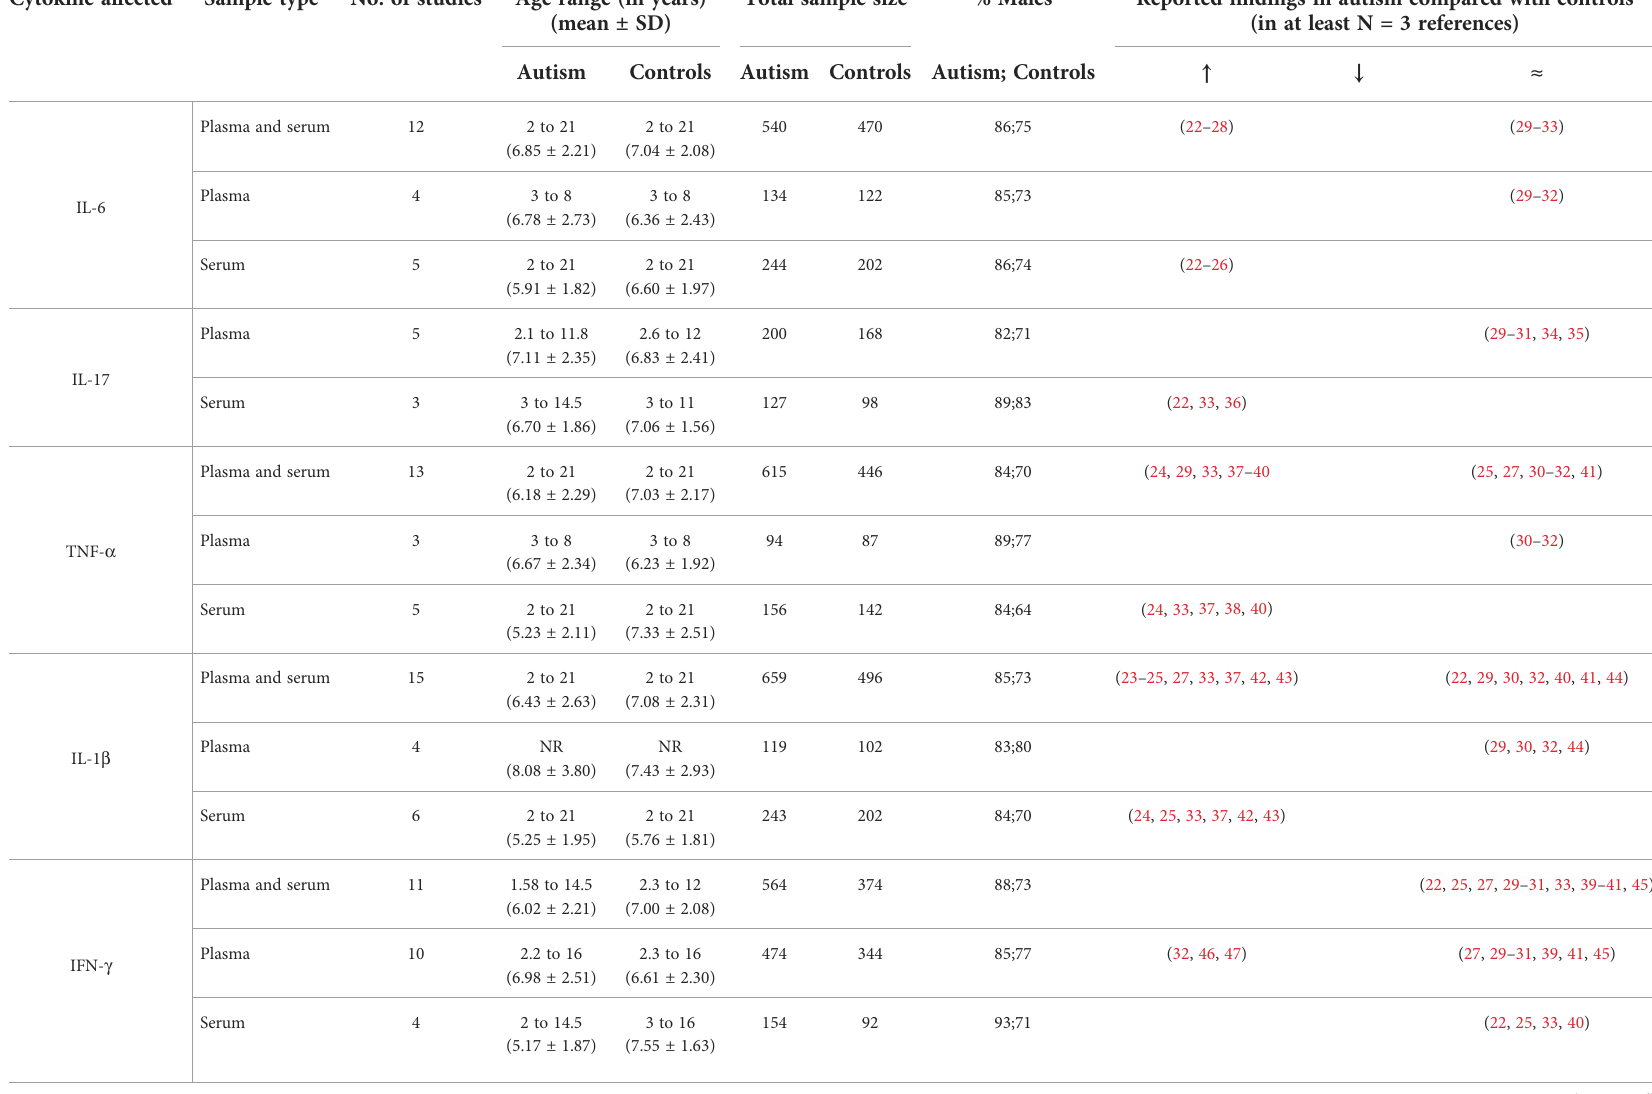
TABLE 1 Baseline levels of cytokines in the blood of individuals with autism compared with